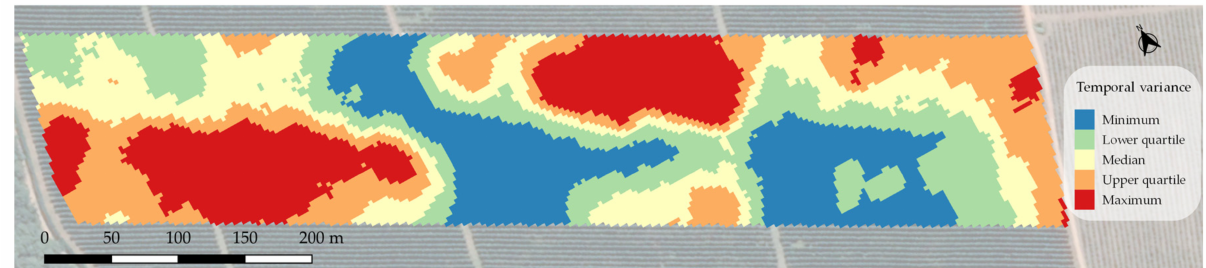
Figure 10. Yield map temporal variance along the three